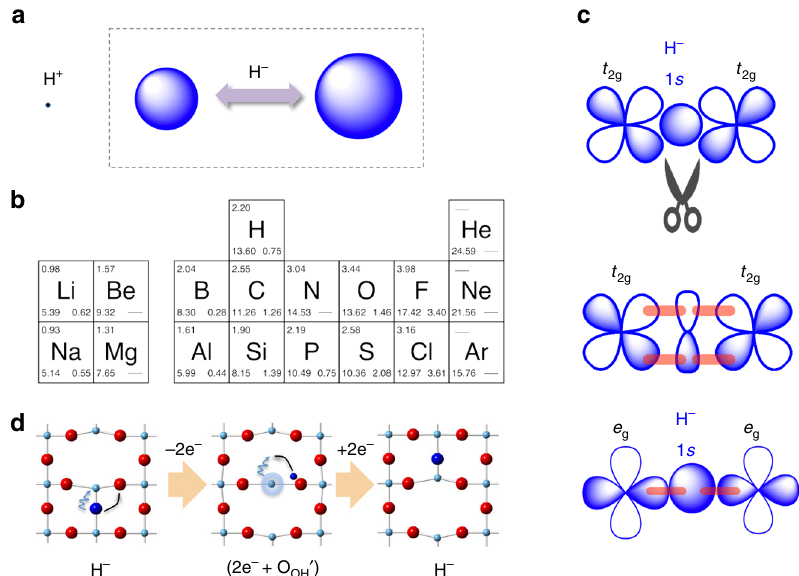
Fig. 2 Speci fi c features of hydride anion H – (Concepts 2a – 2d). a As opposed to other anions, H – is highly fl exible in size (right, exaggerated for clarity),